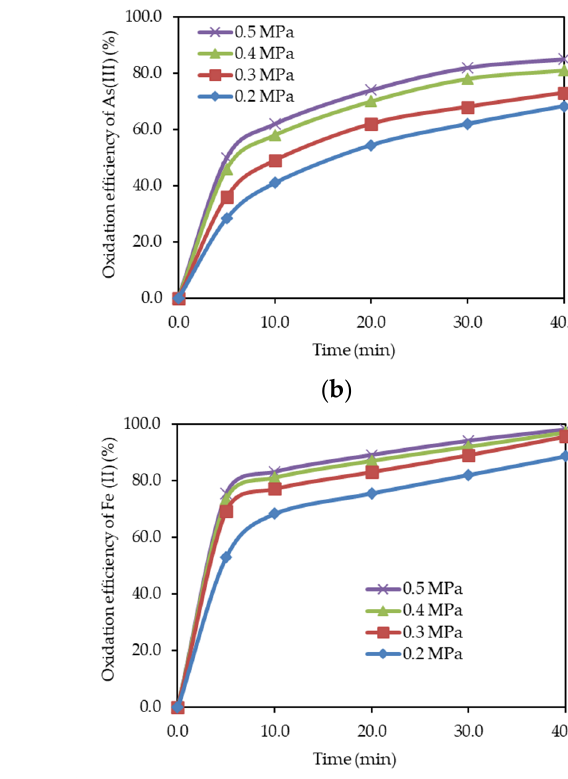
Figure 5. As (III) oxidation efficiency as a function of temperature with ( a ) and without ( b ) Cu (II) ions.